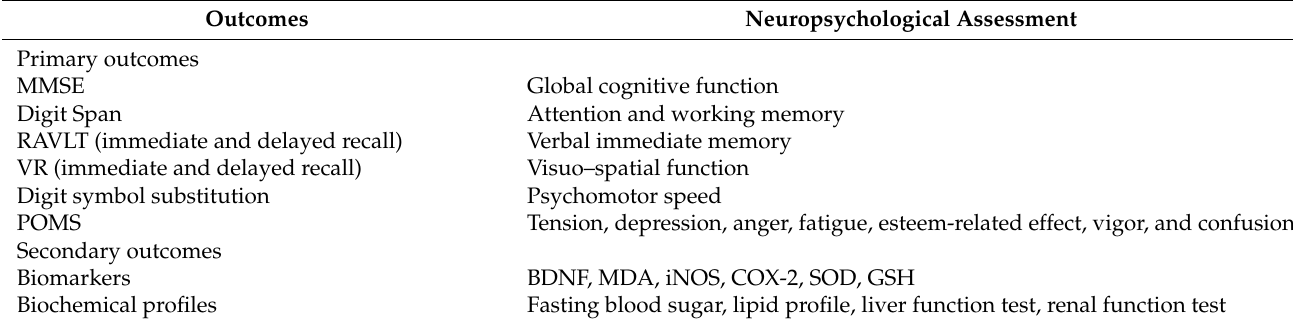
Table 2. Outcomes of the